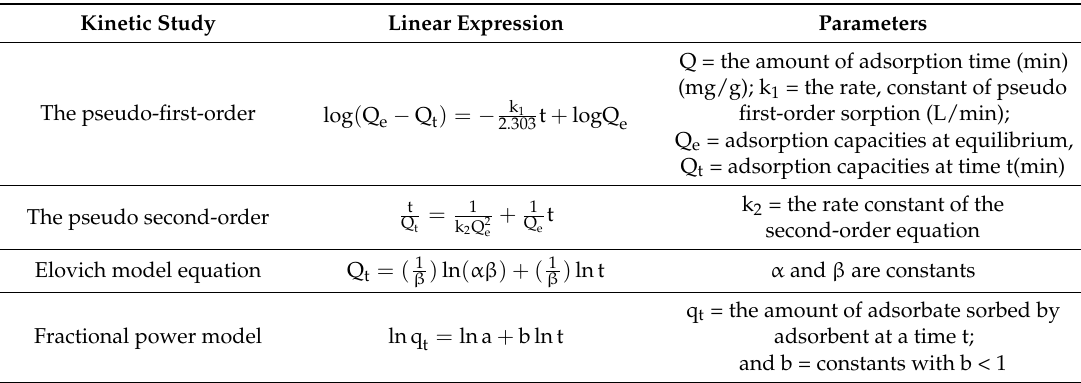
Table 6. Kinetic study models [39,40].